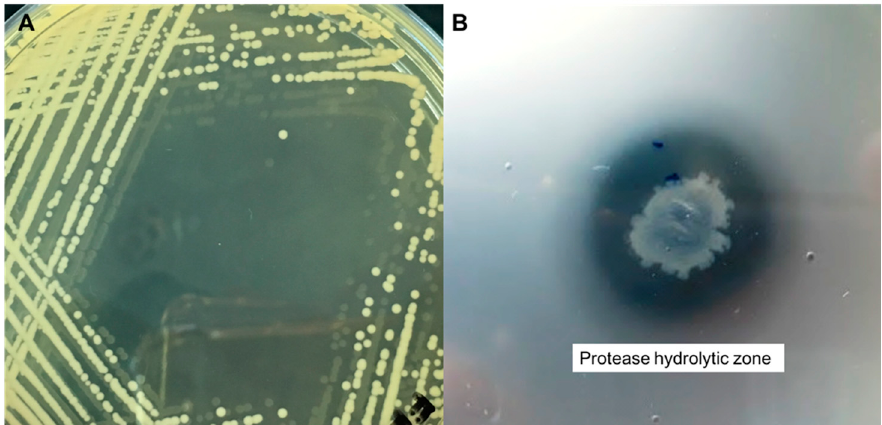
Figure 2. ( A ) Growth and colony morphology of isolate SKF4 on Luria Bertani agar. ( B ) Protease activity of isolate SKF4 on skim milk agar.